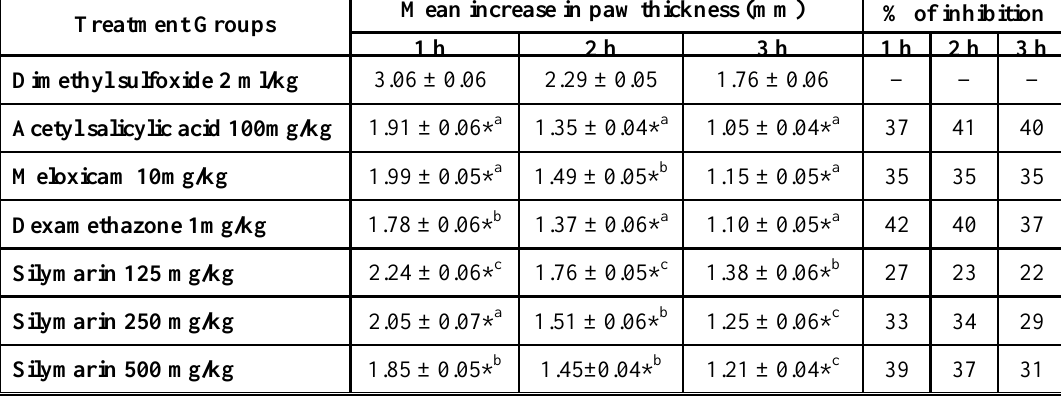
Table 1: Effect of different doses of silymarin on egg albumin-induced acute inflammation in